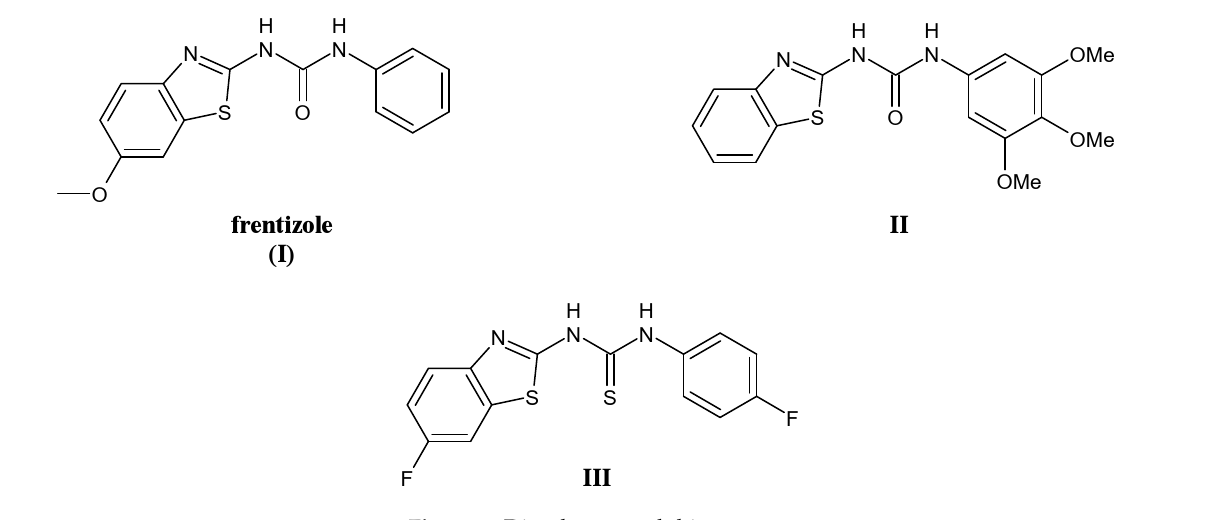
Figure 2. Diarylureas and thioureas.